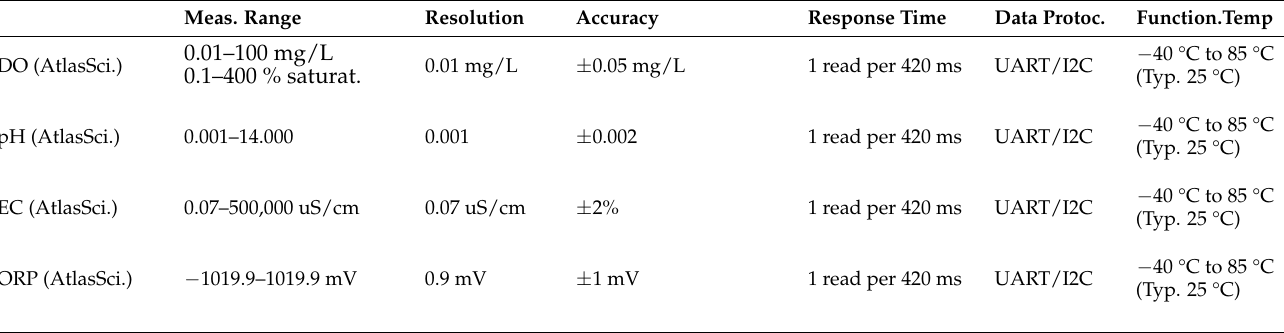
Table 4. Technical specifications for